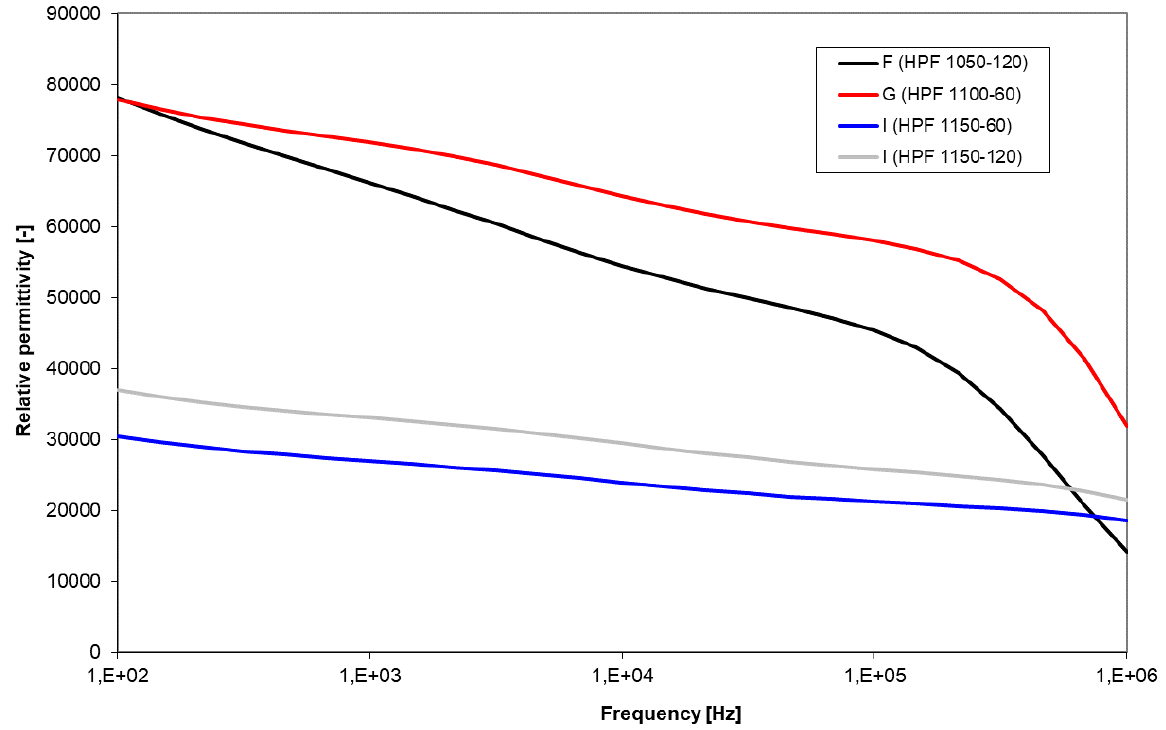
Figure 10. Relative permittivity of four HPF samples (measured at room temperature).